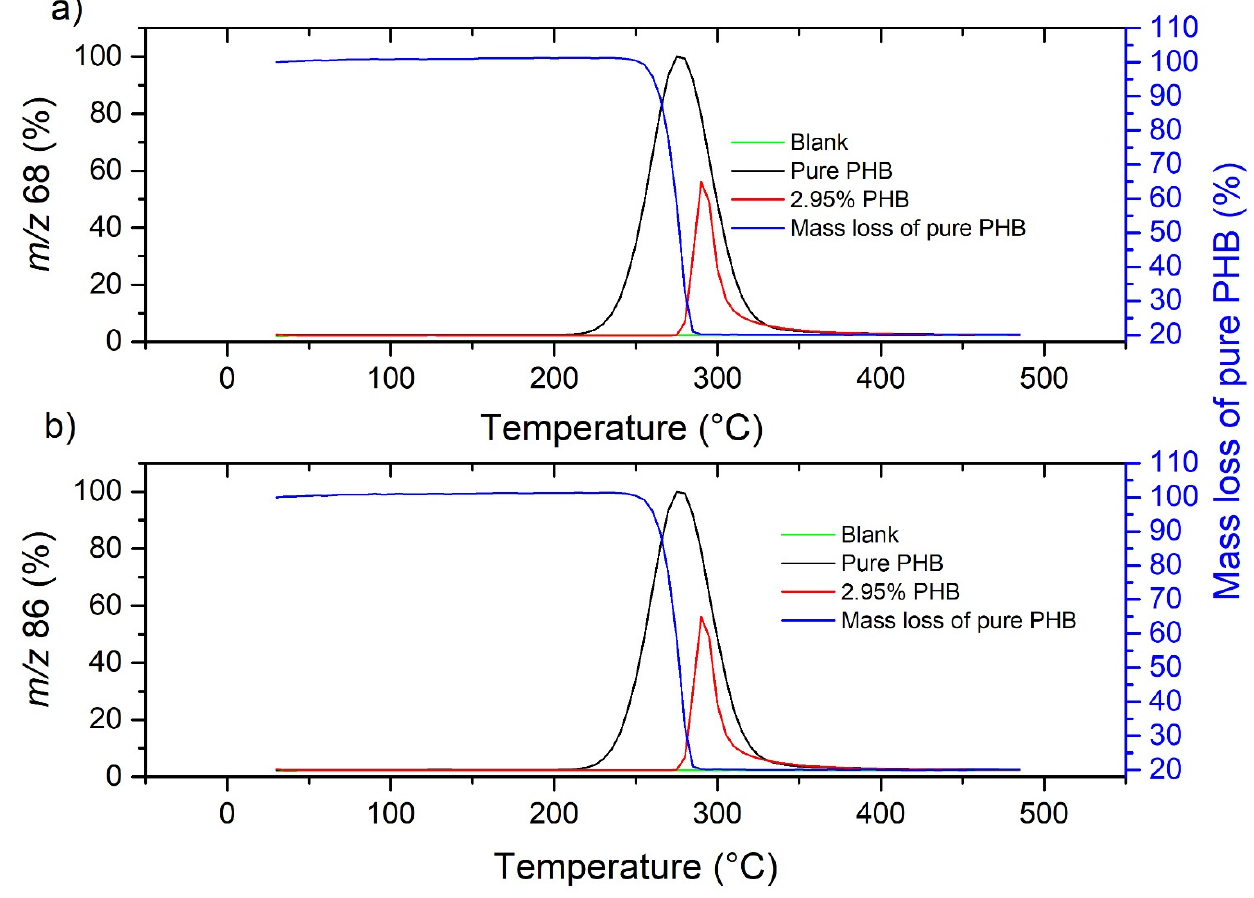
Figure 1. Plots of the peaks at m / z 68 ( a ) and 86 ( b ) of blank, pure PHB and HS5 soil containing 2.95% PHB suitable for PHB detection.